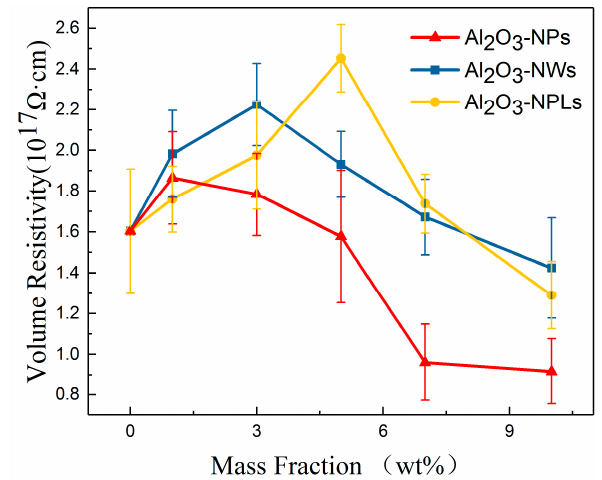
Figure 6. Relationship between the volume resistivity of the composites with the mass fraction of Al 2 O 3 nano-fillers.